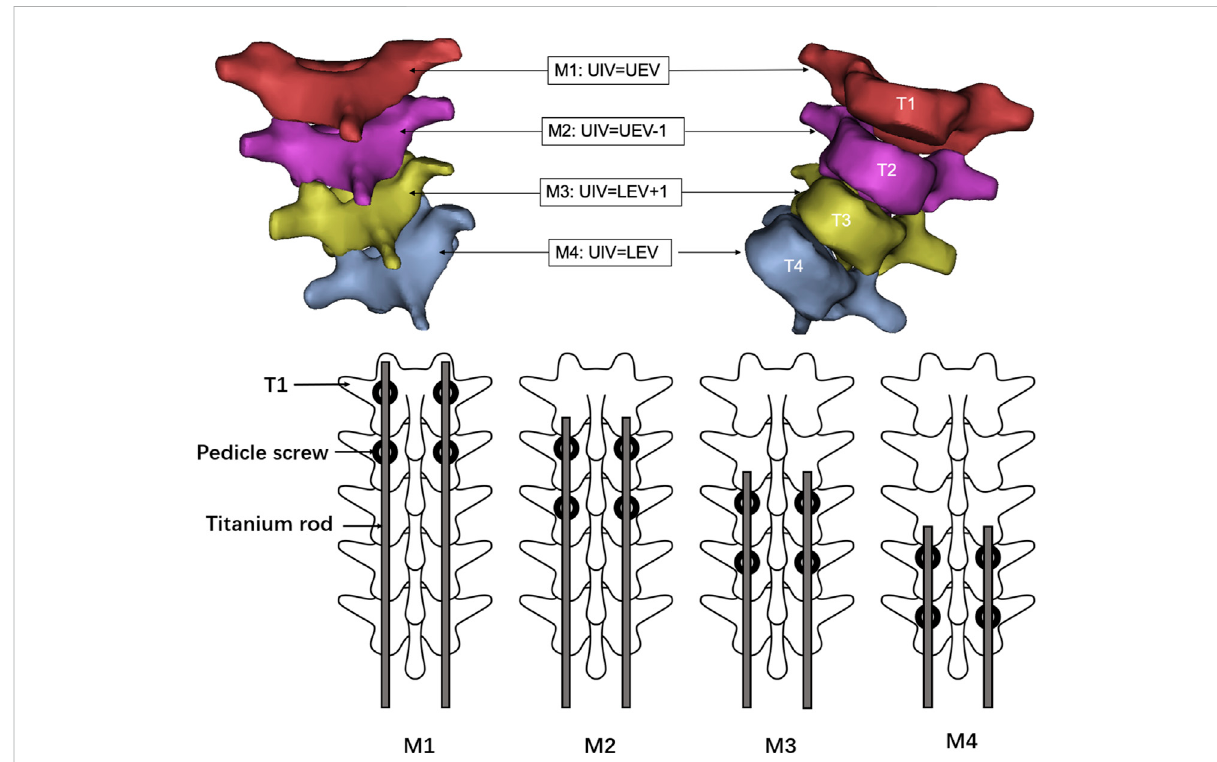
FIGURE 3 Schematicdiagramofinternal fi xationschemeofM1 – M4model.M1:UIV=T1,i.e.,theUEVoftheupperthoraciccurve;M2:UIV=T2,i.e.,UEV-1; M3: UIV = T3, i.e., LEV+1; M4: UIV = T4, i.e., the LEV of the upper thoracic